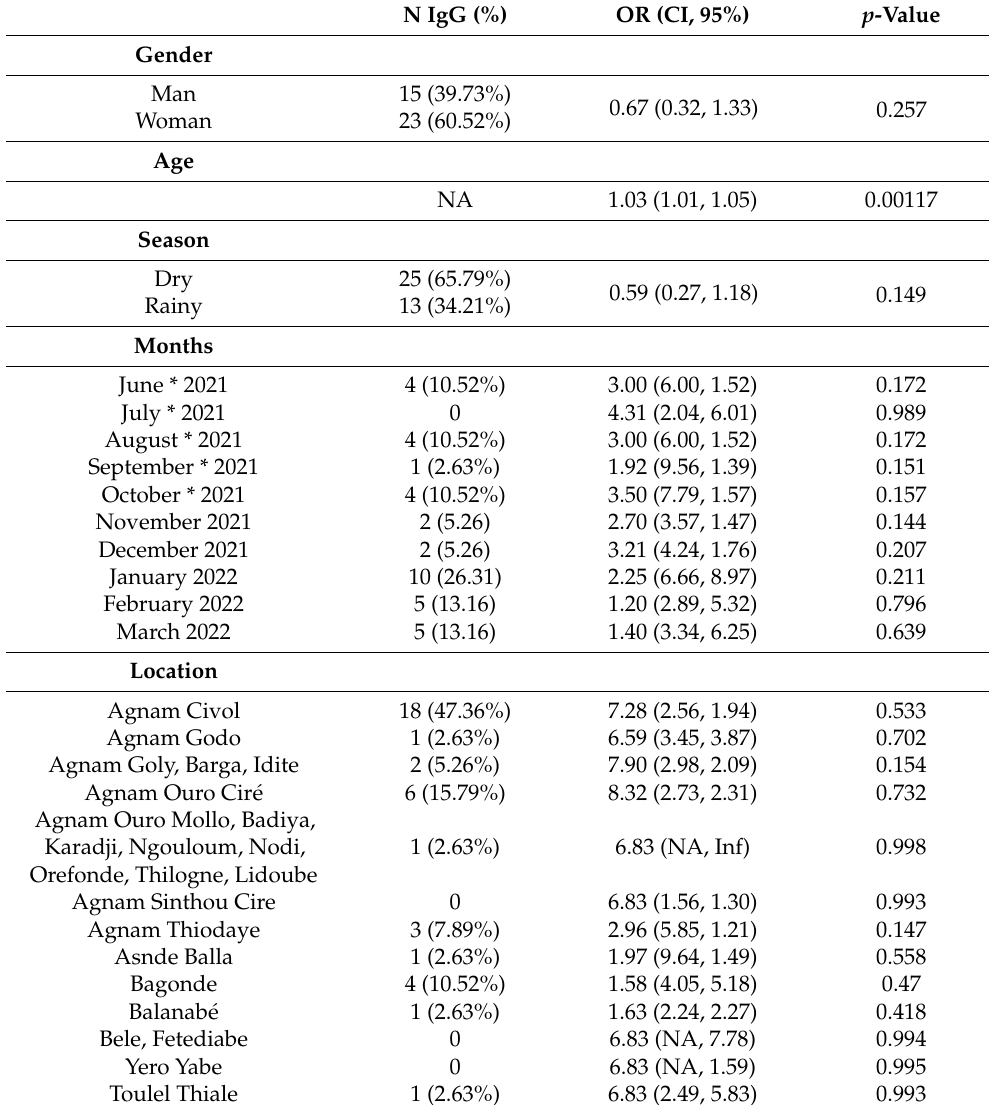
Table 2. Risk factors for CCHFV in human